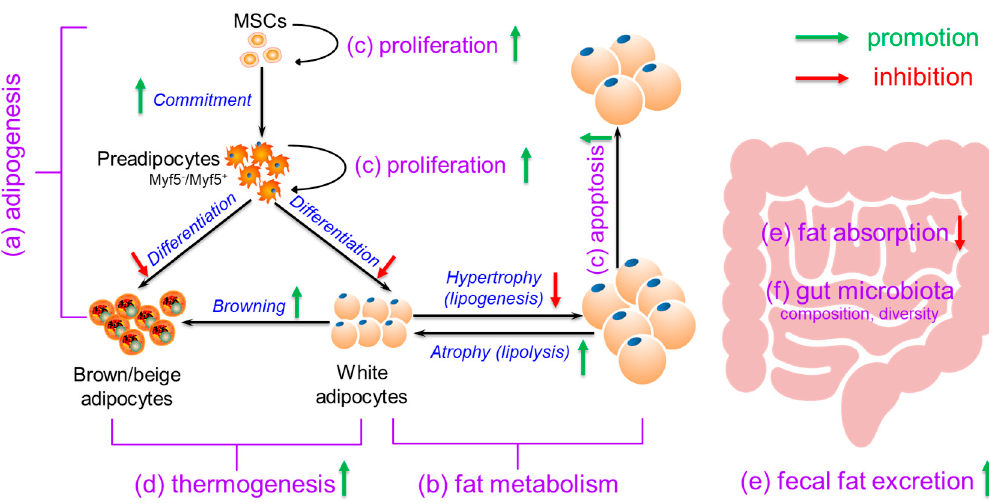
Figure 1. The possible mechanisms for the anti-obesity effects of dietary calcium. Calcium may elicit anti-obesity effects through (a) regulation of adipogenesis, with stimulation on mesenchymal stem cells (MSCs) (or commitment stage) and inhibition on preadipocytes (or differentiation stage); (b) modulation of fat metabolism, with decreased fat synthesis (lipogenesis) and increased fat breakdown (lipolysis); (c) promotion of adipocyte (precursor) proliferation and apoptosis; (d) enhancement of thermogenesis, with increased brown adipose tissue (BAT) activation and white adipose tissue (WAT) browning; (e) suppression of fat absorption and promotion of fecal fat excretion; and (f) modification of gut microbiota composition and diversity.